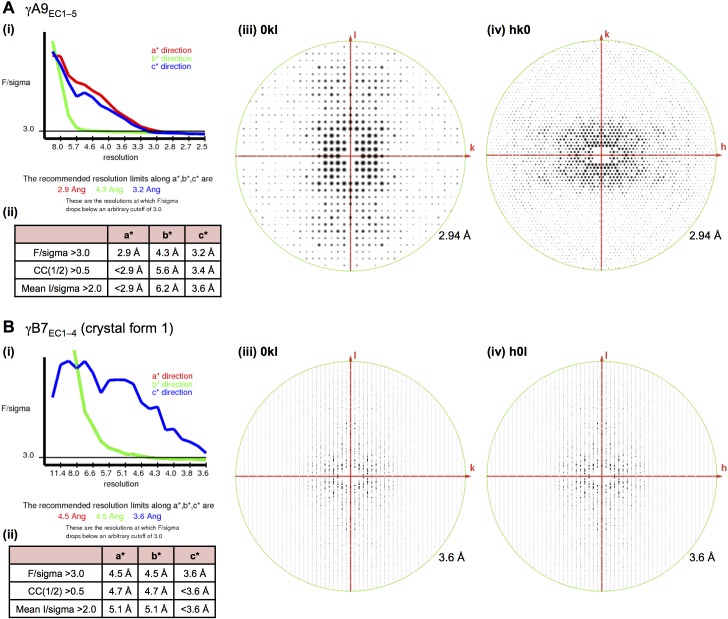
X-ray diffraction anisotropy of the γA9EC1–5 and γB7EC1–4 crystals.(A) γA9EC1–5 crystal (i) UCLA Diffraction Anisotropy Server (Strong et al., 2006) output showing the data strength as measured by F/sigma along the a*, b*, and c* axes. (ii) The diffraction limits along the a*, b* and c* axes determined by three different methods: F/sigma from (i), and the correlation coefficient (CC) and I/sigma limits calculated by Aimless (Evans, 2006; Evans and Murshudov, 2013). (iii–iv) Synthetic precession photographs of the X-ray diffraction in the h = 0 plane (iii) and the l = 0 plane (iv) showing the weaker diffraction along k. (B) γB7EC1–4 crystal form 1 (i) and (ii) as above. (iii–iv) Synthetic precession photographs of the X-ray diffraction in the h = 0 plane (iii) and the k = 0 plane (iv) showing the weaker diffraction along k and h.